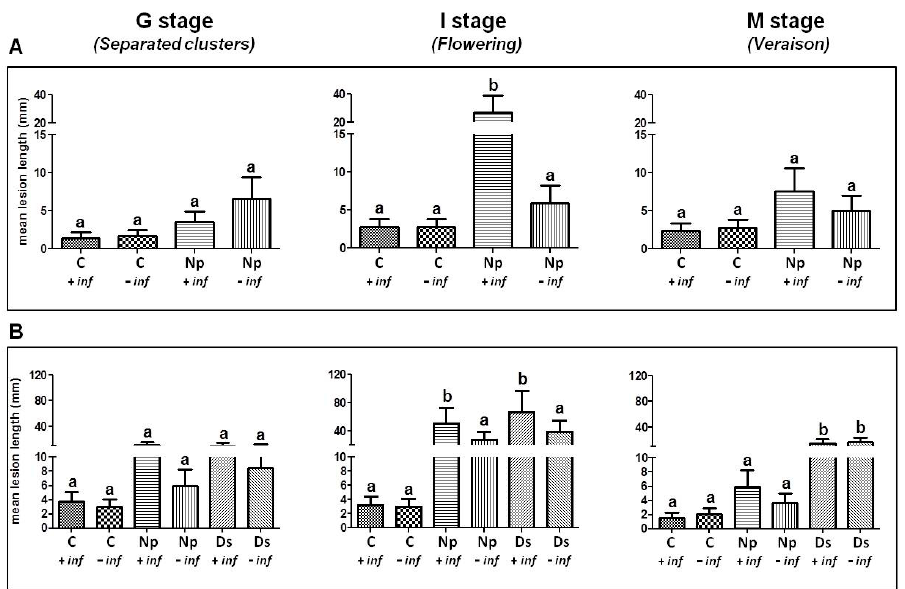
Figure 1. Mean lesion lengths ± SE on green stems after artificial inoculation at the onset of the G stage, flowering and veraison with: ( A ) N. parvum (Np) and ( B ) N. parvum (Np) or D. seriata (Ds) the in presence (+inf) or absence ( − inf) of inflorescences; control stems (C + inf, C − inf) were wounded and inoculated with sterile malt agar. Differences among the means were evaluated by Dunn’s multiple comparison test; after that the null hypothesis (equal means) was rejected in the Kruskal–Wallis test, assuming a significance of p ≤ 0.05. The same letter above columns indicates no statistically significant differences for p ≤ 0.05.